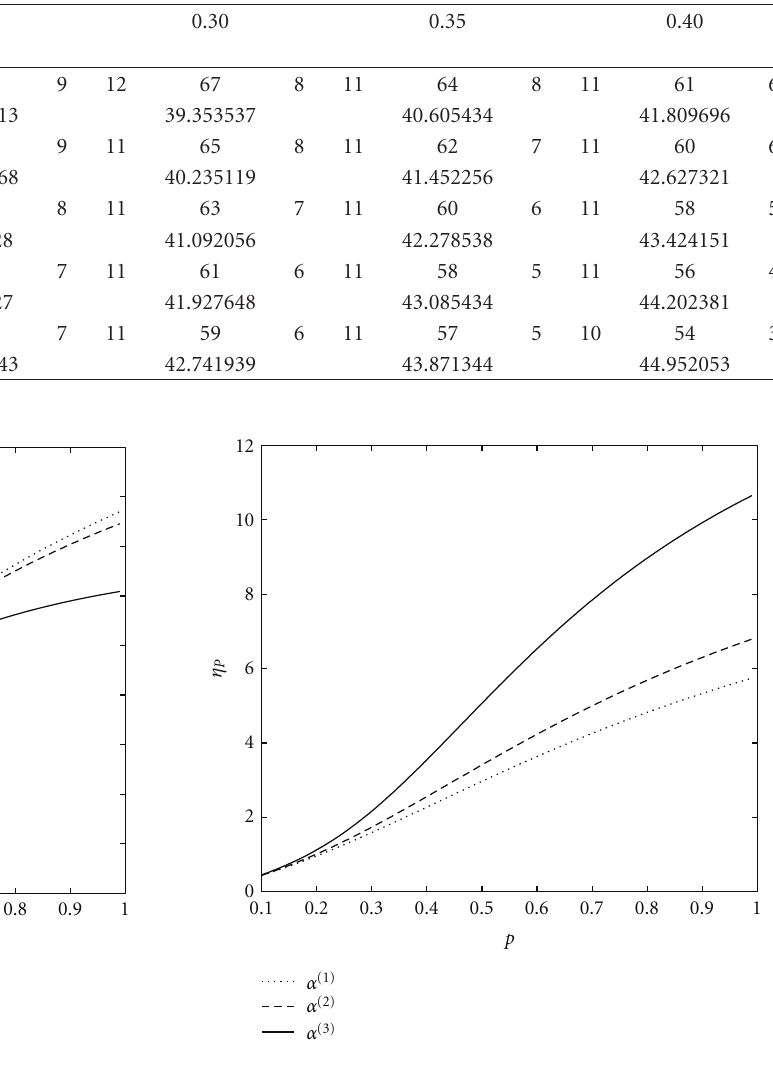
Figure 9: Expected number of customers in the pool— p versus α ( n ) ( S = 90, s = 15, N = 25, λ = 8, β = 1 . 4, γ = 0 . 7, μ = 0 .